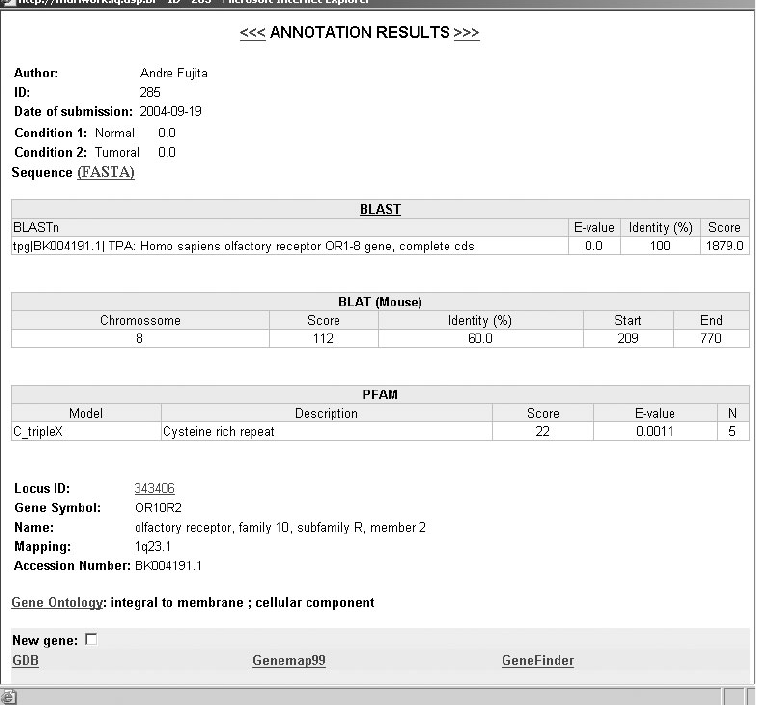
Figure 1 . GATO output. A user friendly graphical view which facilitates data interpretation.